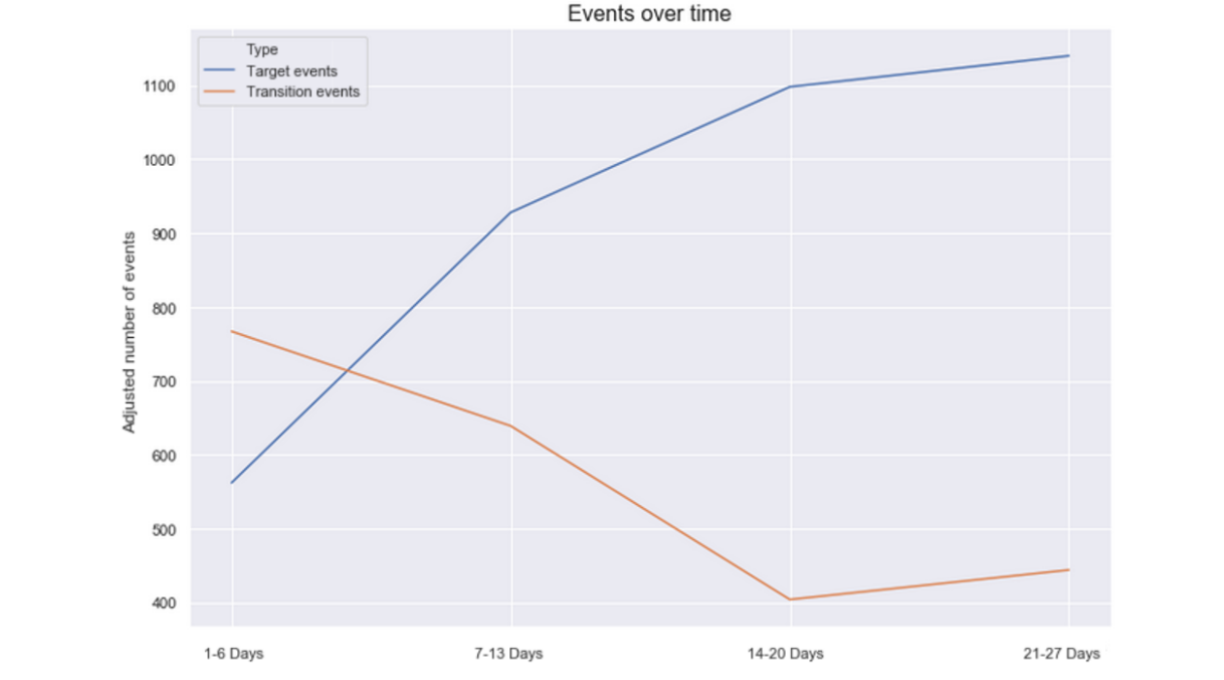
Figure 4. Target and transition events over